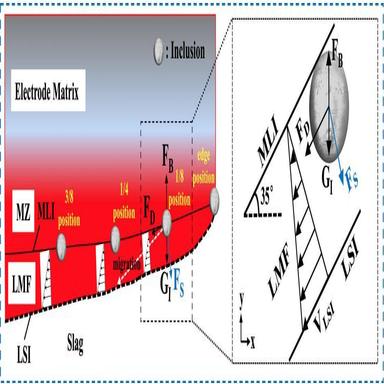
Schematic diagram of the FS driving inclusions to LSI and geometric model adapted in this study, MLI: MZ/LMF interface, LSI: LMF/slag interface, VLSI: flow velocity of LSI, FD: drag force, FB: buoyancy force, GI: gravity force, FS: Saffman force, respectively.